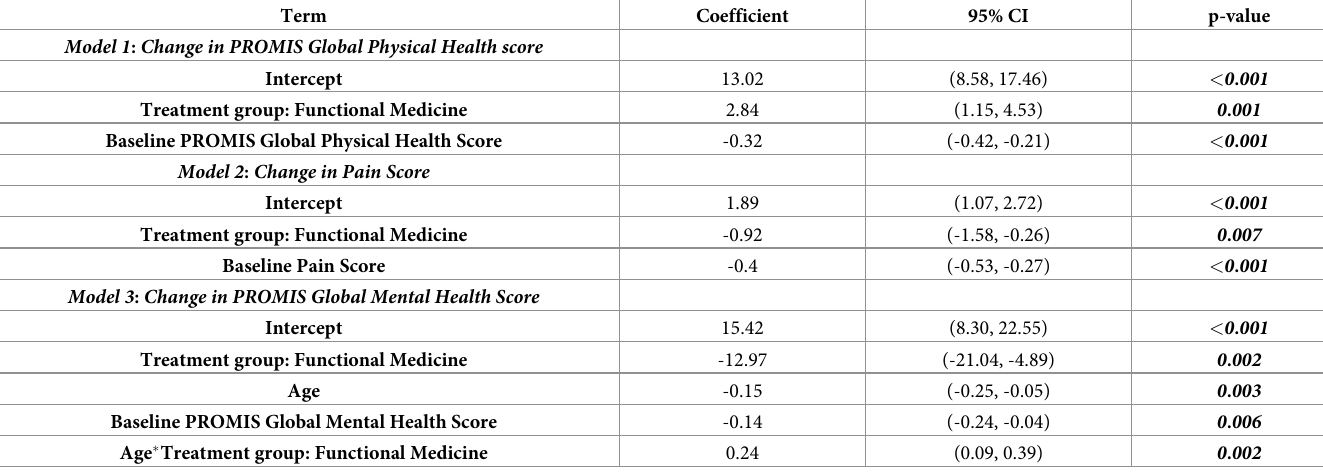
Table 3. Results for multivariable